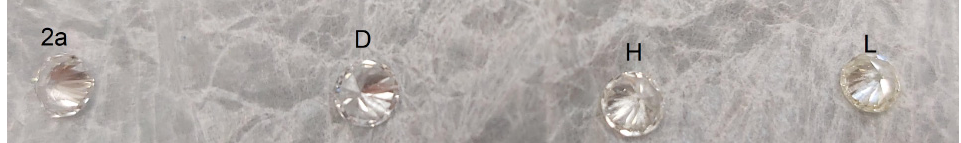
Figure 1. Four master diamonds with different nitrogen concentrations. From left to right: 2a (D color grade), D (D color grade), H (H color grade), and L1 (L color grade). The master diamonds were graded by the GIA (Gemological Institute of America).